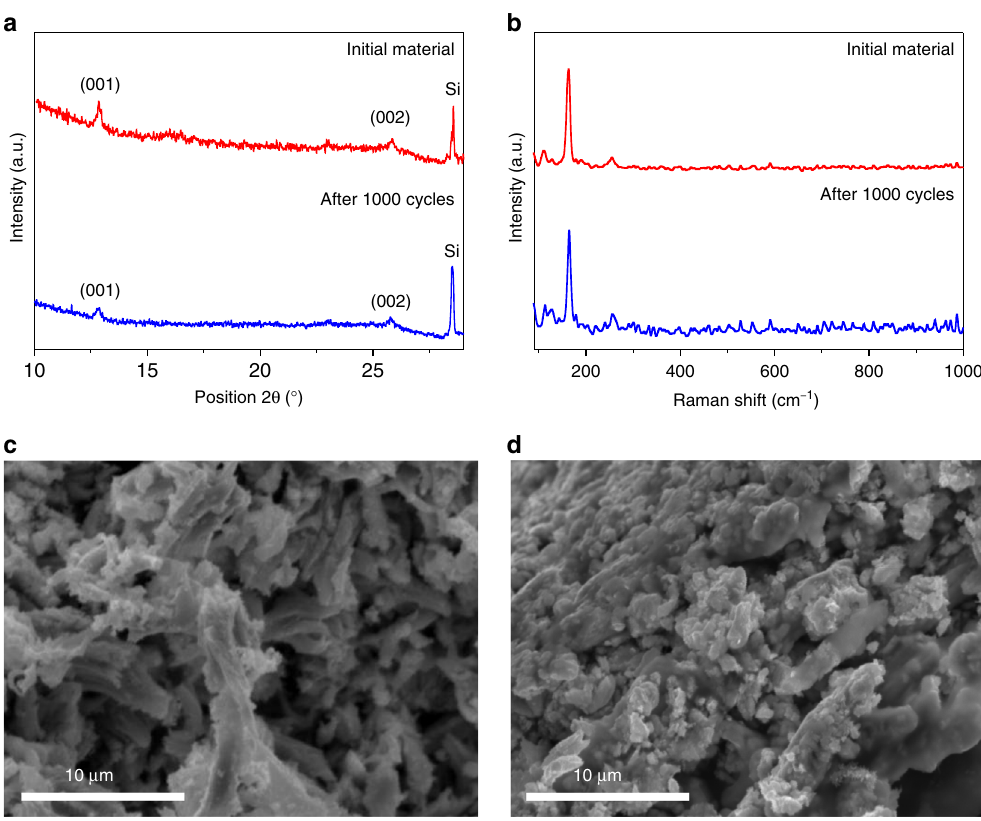
Fig. 3 Stability studies of nanocrystalline 1T ′ -MoTe 2 . a PXRD patterns of nanocrystalline 1T ′ -MoTe 2 before and after 1000 cycles. Patterns were measured directly on the surface of the glassy carbon working electrode on which the catalyst ink was deposited. A small amount of silicon powder was placed on the surface to act as an internal standard. PXRD patterns obtained after electrocatalytic measurements were performed directly on the electrode surface; therefore a layer of H 2 SO 4 electrolyte is present and may result in weaker Bragg re fl ections. b Wide-range Raman spectra of nanocrystalline 1T ′ -MoTe 2 measured before (top) and after 1000 cycles (bottom). Raman spectra obtained after electrochemical measurements were performed directly on the electrode surface, therefore a layer of H 2 SO 4 electrolyte is present thus resulting in an increased background after 1000 cycles. Particle morphologies of nanocrystalline 1T ′ -MoTe 2 before ( c ) and after cycling ( d